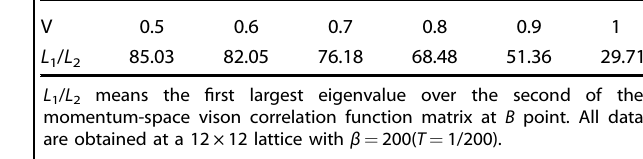
ffiffiffiffiffi p ffiffiffiffiffi p ´ 12 12 VBS phase at V = 0.